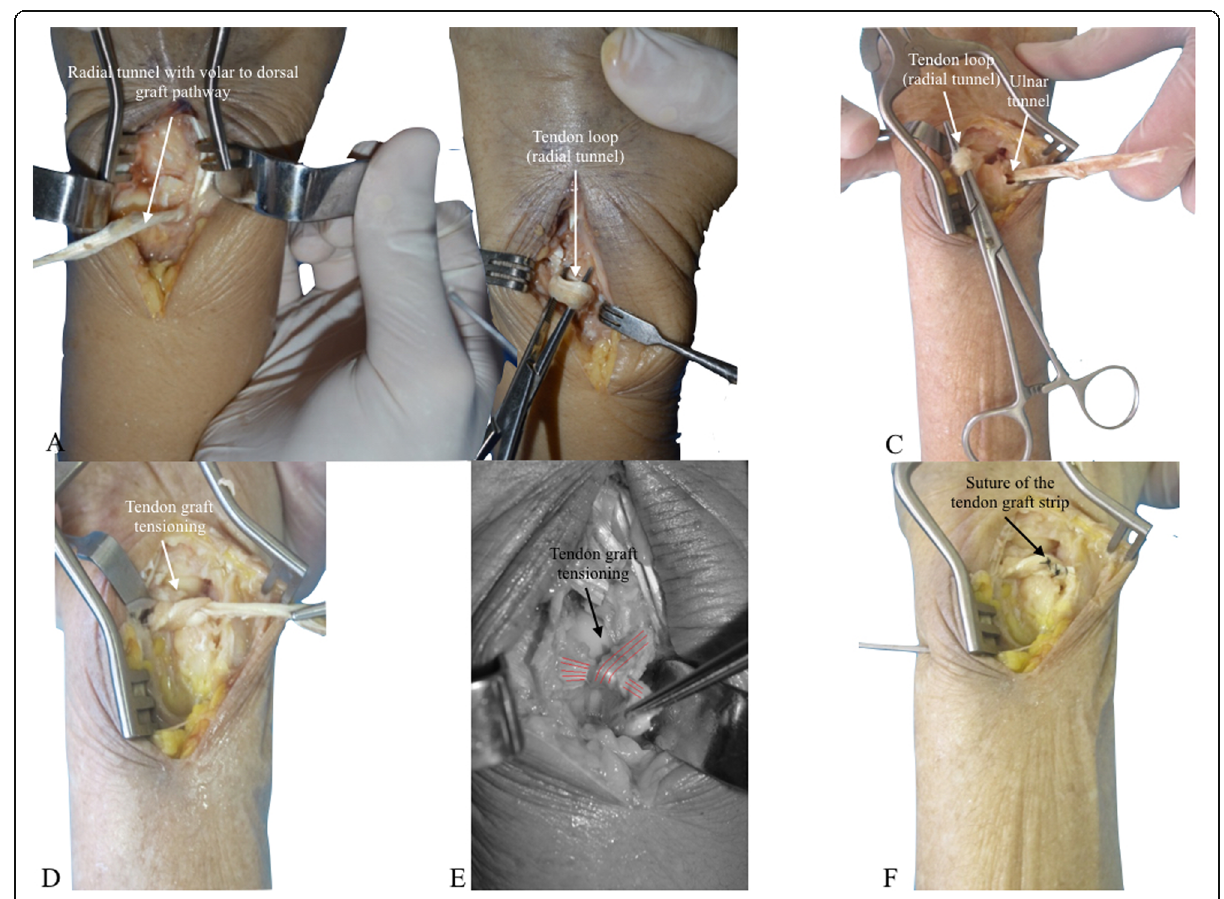
Fig. 3 a Radial tunnel with volar to dorsal graft pathway; ( b ) Dorsal view of the wrist showing the dorsal tendon loop; ( c ) Dorsal view of the wrist showing the tendon placed through the ulnar tunnel; ( d ) Dorsal view showing tendon graft tensioning; ( e ) Red lines depicting tendon graft tensioning; ( f ) Suture of the tendon graft. Observe the K-wire for joint reduction